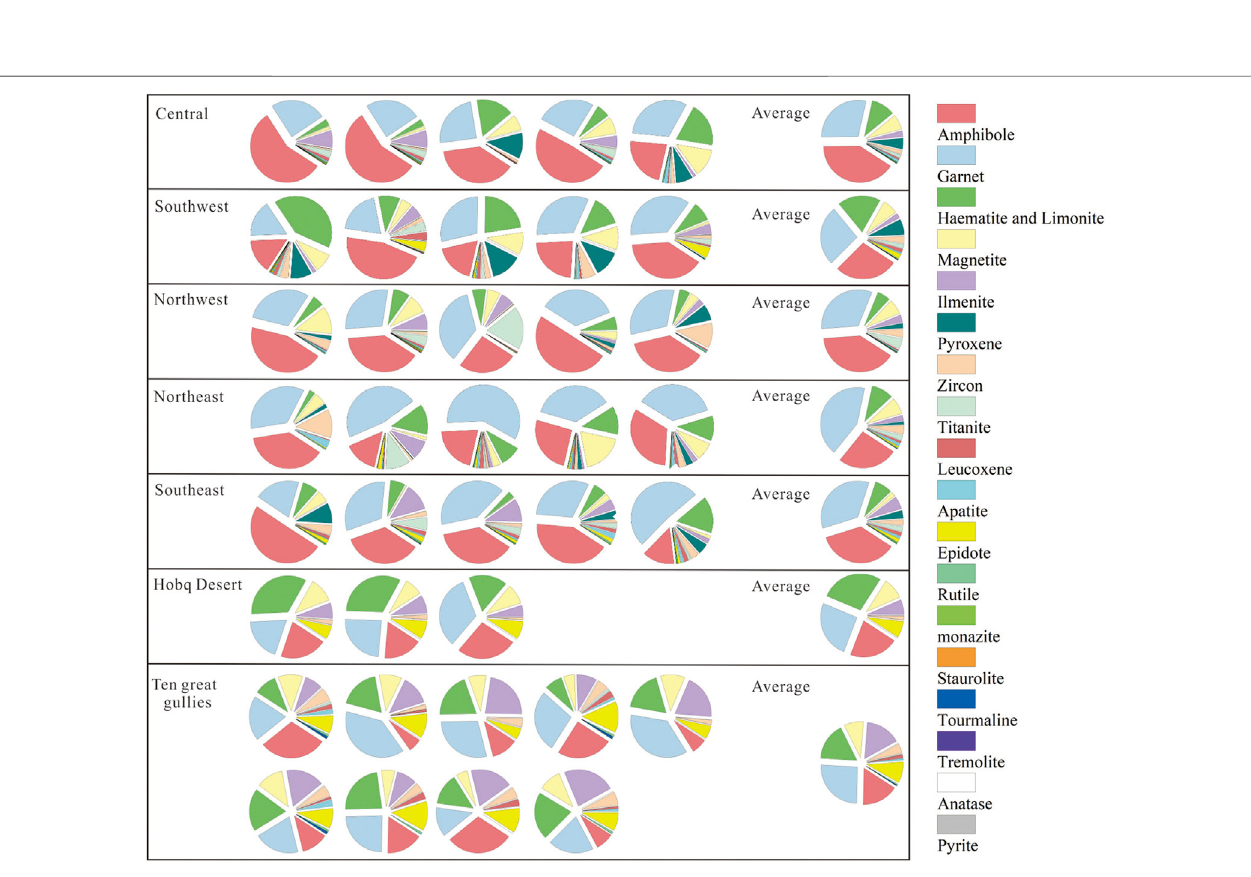
Frontiers in Earth Science |